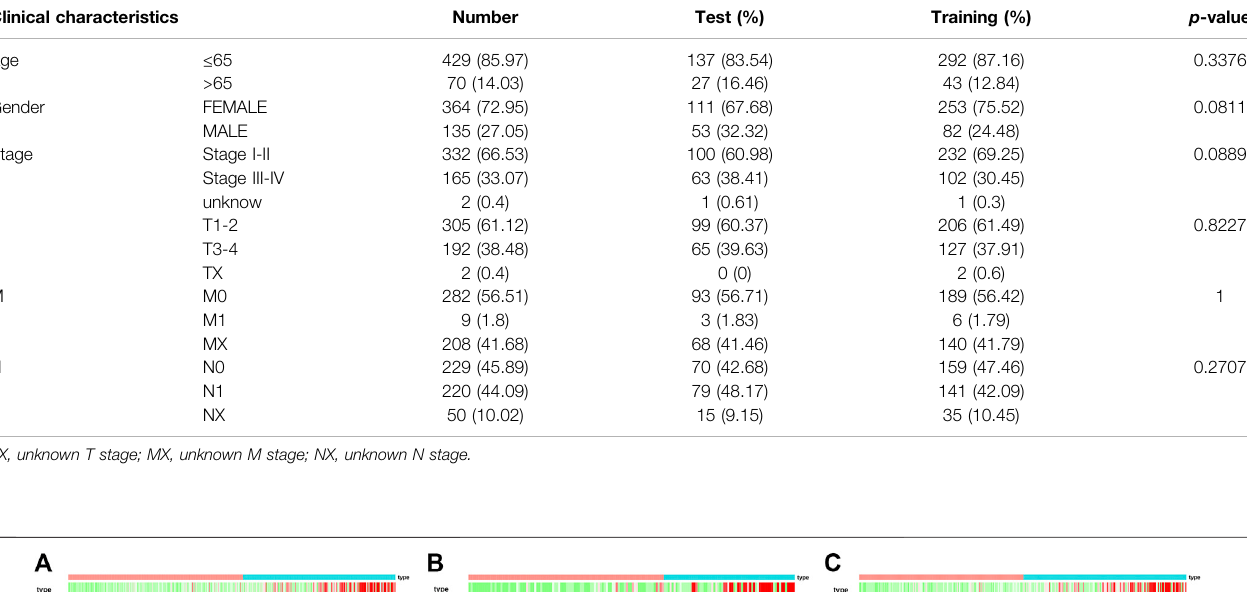
TABLE 2 | Clinical characteristics between test and training cohorts.